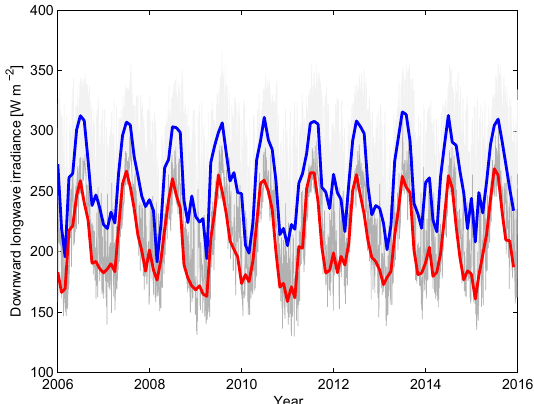
Figure 3. The time series of pyrgeometer sensitivities ( C ) used for scenario 4 to revise the 2006–2015 NYA DLR time series. Verti- cal lines represent deployment periods of different pyrgeometers at NYA, for which details are listed in Table